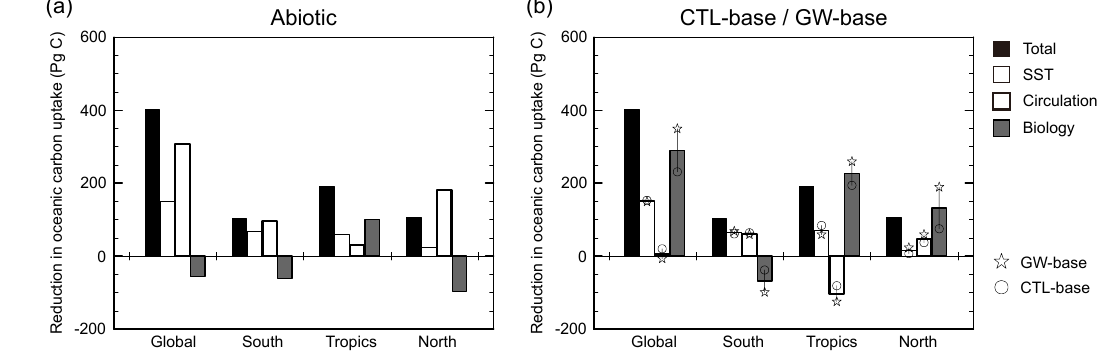
Figure 5. Contributions of the primary mechanisms to the reduction in the oceanic CO 2 uptake due to global warming at 500 years for (a) the abiotic experiments and (b) the CTL-base and GW-base experiments. Total change and effects of SST, circulation, and biology are calculated as summarized in Table 2. The biological effect in the abiotic experiments is calculated as the residual. The biological effect in CTL-base and GW-base represents the effect of the organic matter cycle. Contributions of the individual mechanisms are separated into three regions (South: south of 32.5 ◦ S; Tropics: 32.5 ◦ S to 32.5 ◦ N; North: north of 32.5 ◦ N). In panel (b) , bars refer to the averages of CTL-base and